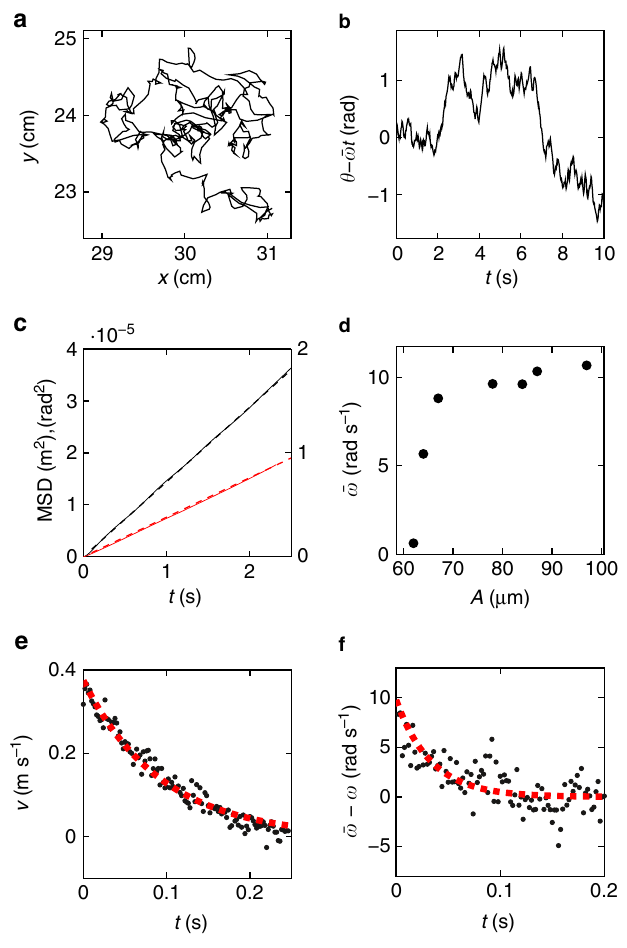
Fig. 5 Dynamic properties of a single rotor. a Example trajectory of a rotor on the vibrating table. b Particle orientation in the co-rotating frame of reference θ (cid:2) ω t . c Mean squared displacement of translational (red) and rotational (black) degrees of freedom. d Average angular velocity ω at constant frequency f = 80 Hz in dependence on the excitation amplitude A . e Relaxation of translational velocity after a kick. f Relaxation of angular velocity after releasing a particle. Fits with linear functions ( c ) and exponentials ( e , f ) are shown with dashed curves